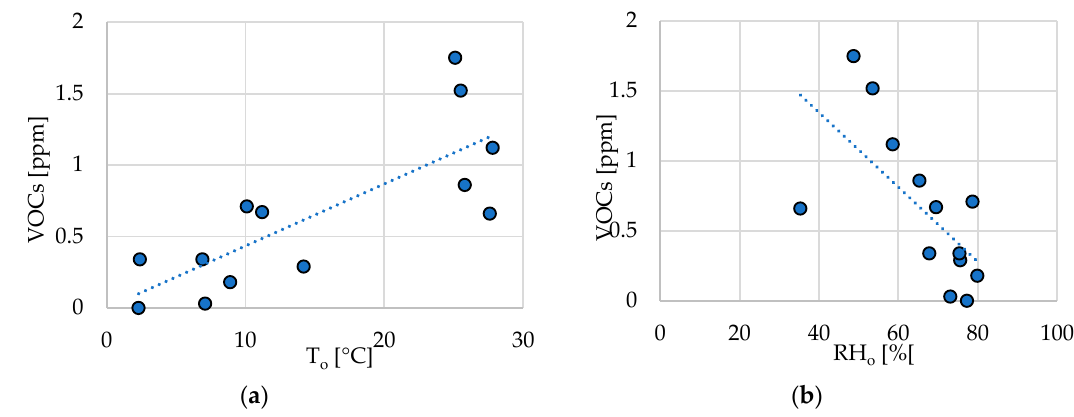
Figure 13. Correlation diagrams between VOC concentration in front of the mechanical treatment hall entrance at biogas plant B and measured microclimatic parameters, with regression lines: ( a ) R 2 = 0.62, ( b ) R 2 = 0.43.